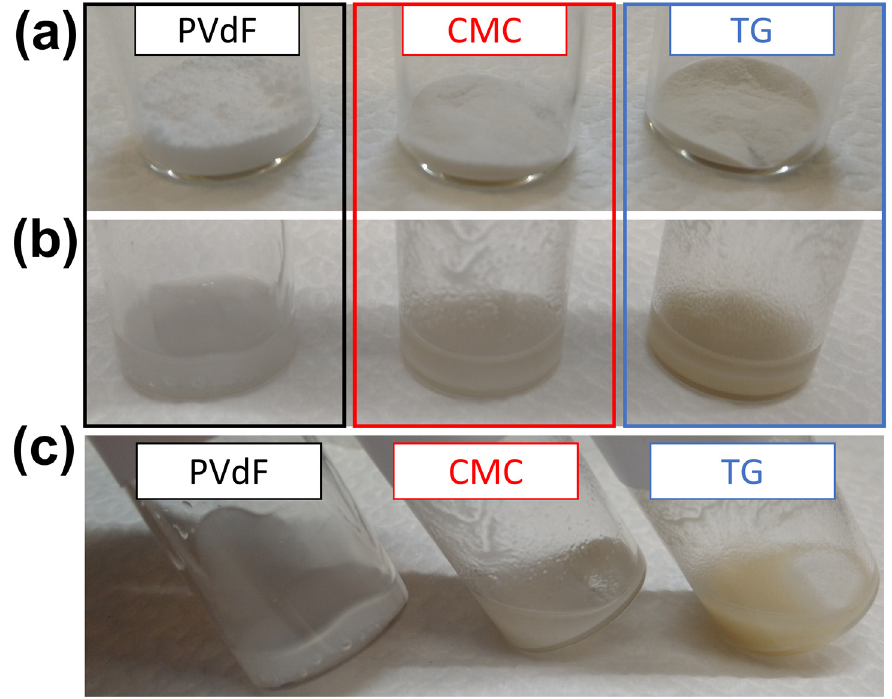
Figure 2. Solubility and swelling test of PVdF, CMC, and TG using LiPF 6 1 M 1:1 v / v in EC:DEC electrolyte: ( a ) after electrolyte addition; ( b , c ) after 24 h.